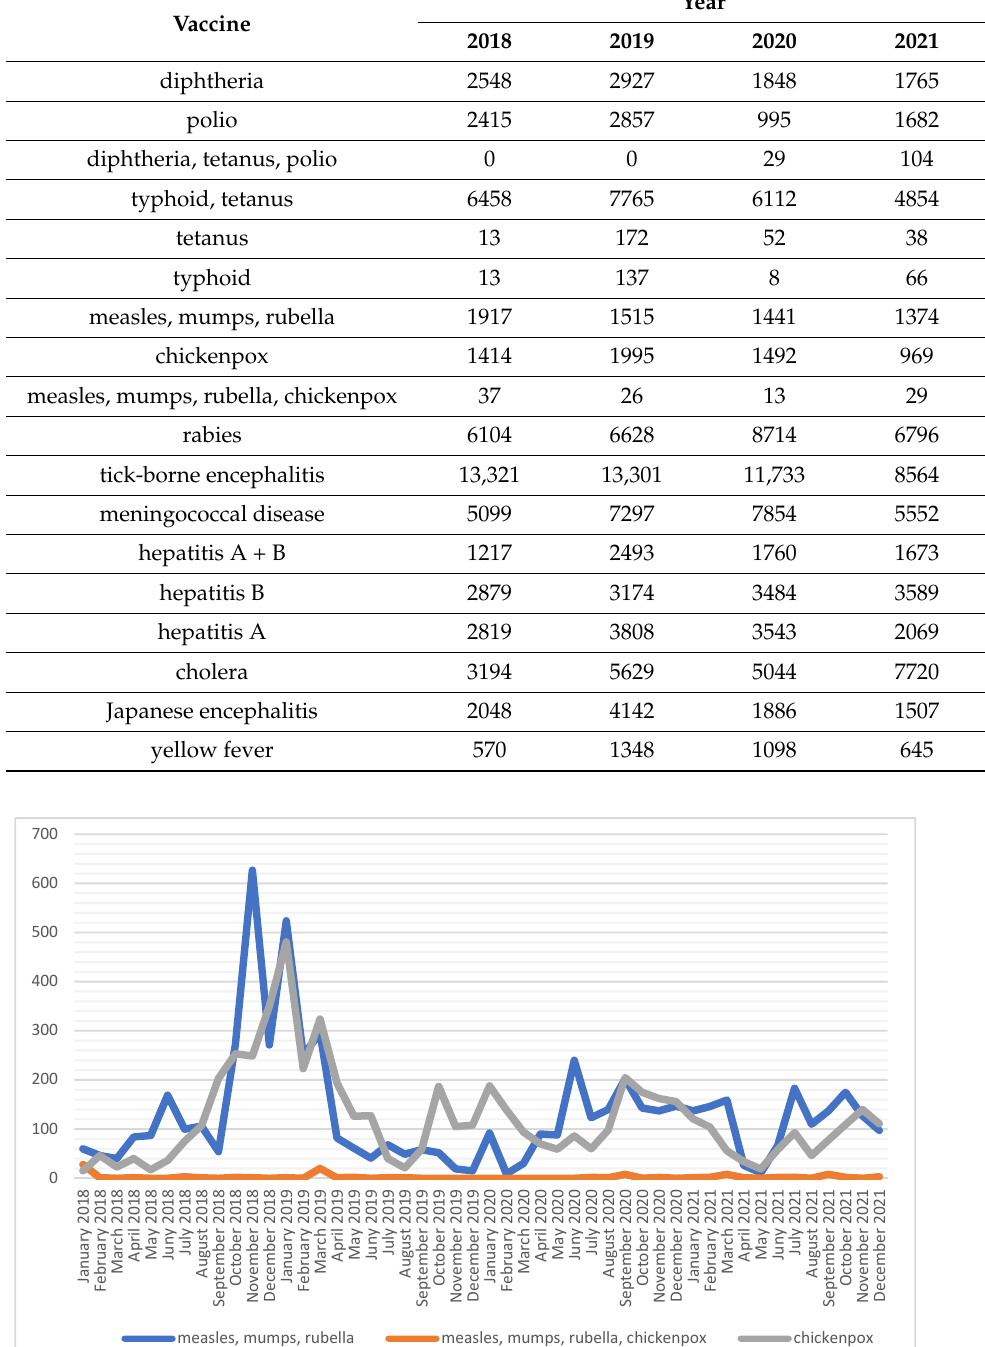
Figure 3. Number of vaccinations against measles, mumps, rubella and chickenpox among soldiers in 2018–2021.